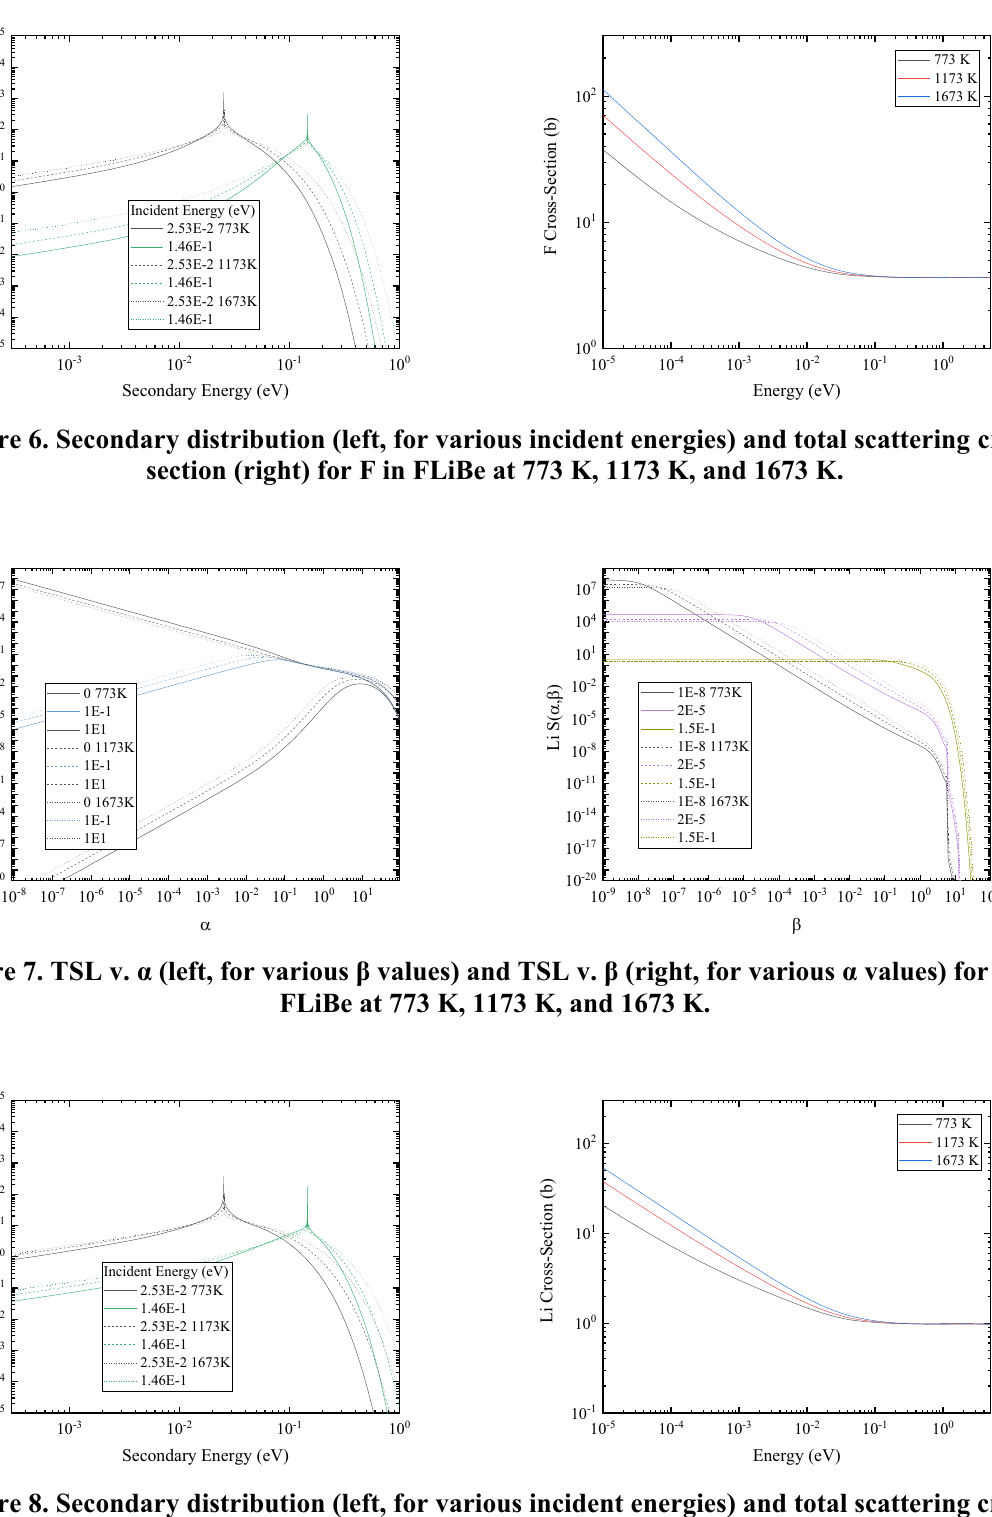
Figure 8. Secondary distribution (left, for various incident energies) and total scattering cross- section (right) for Li in FLiBe at 773 K, 1173 K, and 1673